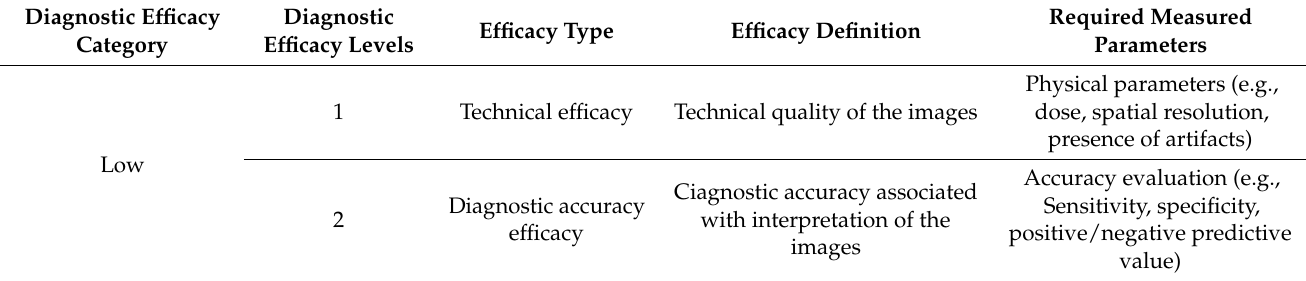
Table 1. Diagnostic efficacy levels and categories of CBCT in endodontics